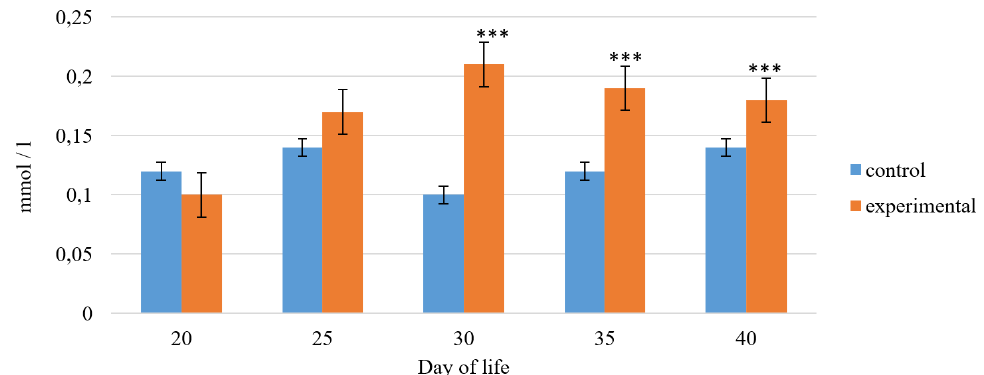
Fig. 3. The level of reduced glutathione in the blood of piglets under the action of feed additive “Butaselmevit-plus” At 30 days of age, the control group of piglets showed a decrease in the studied indicator, while the experimental group of piglets fed with Butasselmevit-Plus feed increased the content of reduced glutathione in 2.1 times compared to the control group of piglets. In the 40-day-old piglets of the experimental group, the content of reduced glutathione re- mained at a high level compared with the control group, where it was correspondingly higher by 28.6